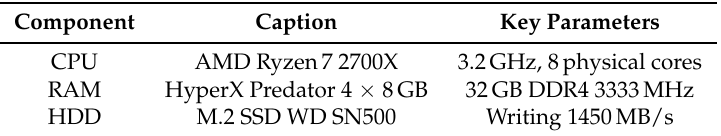
Table 1. Hardware used for